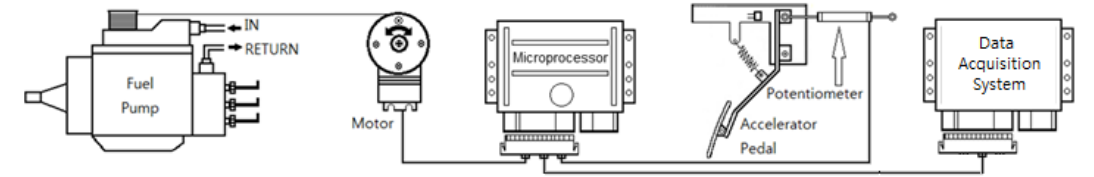
Figure 16. Schematic diagram of the throttle actuating system.